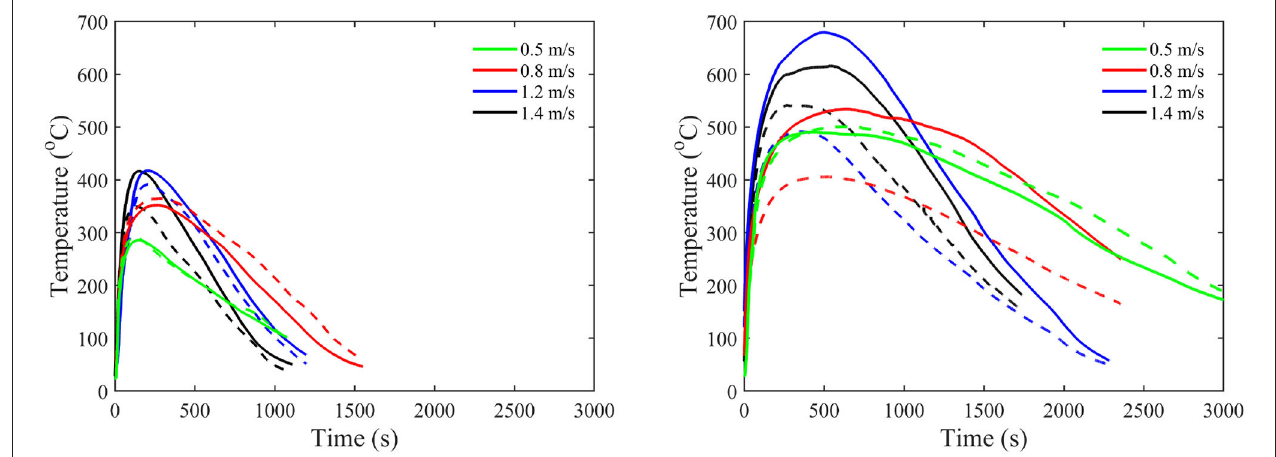
FIGURE 5 | Averaged TSC temperatures for (left) a 4 g deposited mass pile and (right) a 16 g deposited mass pile. Solid lines represent inner TSCs; dashed lines represent outer